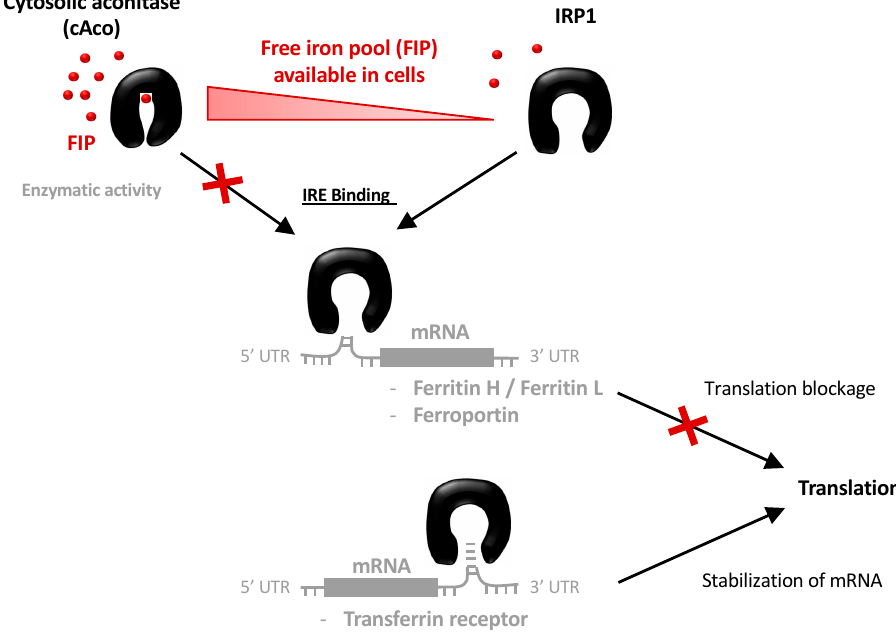
Scheme 1. Mechanism of the regulation of FIP level by the cAco/IRP1 conformational equilibrium and the binding with IRE